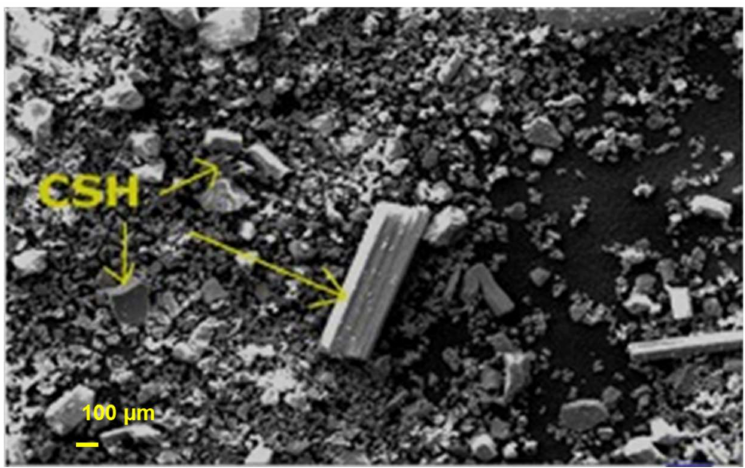
Figure 6. Microradiograph for scanning electron microscopy of calcium sulfate hydrate–hydroxyapatite powder showing calcium sulfate hydrate in rectangular and rod-like shapes (arrows) and smaller particles of hydroxyapatite. Scale bar = 100 µ m. calcium sulfate